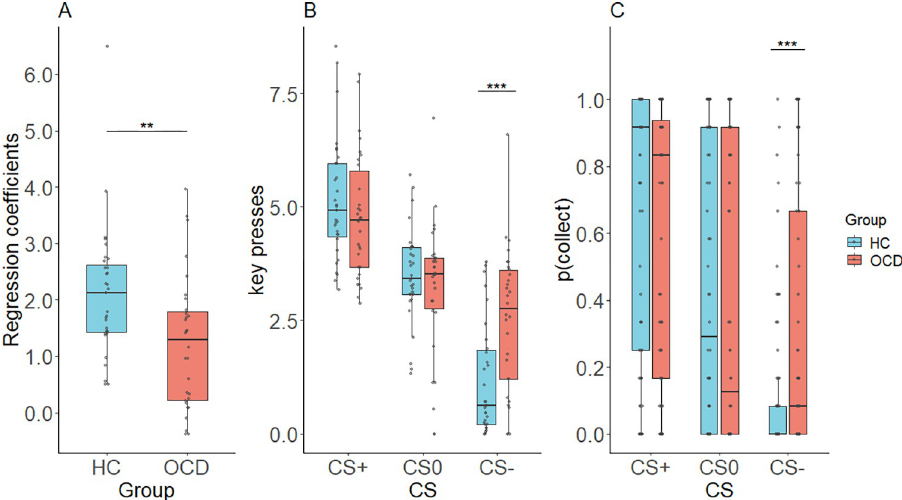
Fig 3. PIT effects during Pavlovian-to-instrumental transfer. (A) The magnitude of the overall PIT effect quantified by linear regression coefficients by regressing each subject’s mean number of key presses onto positive, neutral, and negative CSs. (B) Mean key presses under each Pavlovian condition. (C) Mean probability of collecting under each Pavlovian